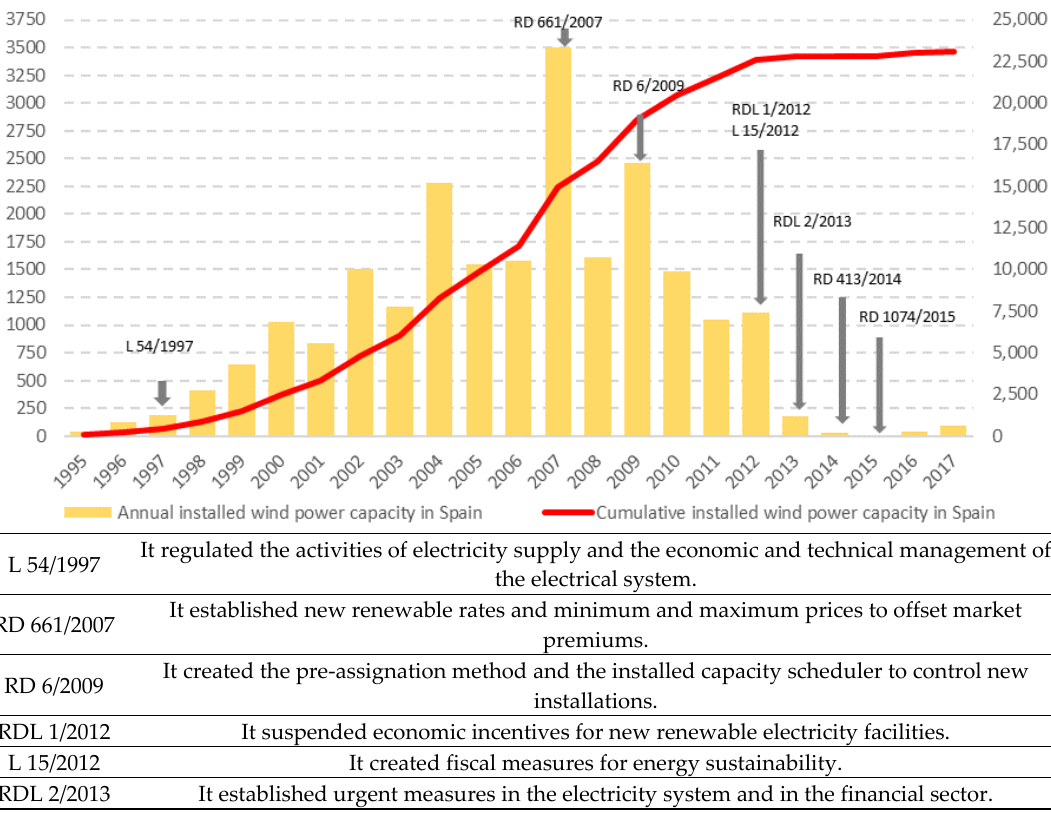
Figure 3. Wind energy capacity by regions in Spain (MW) (1998 – 2017) elaborated from [70 – 72].